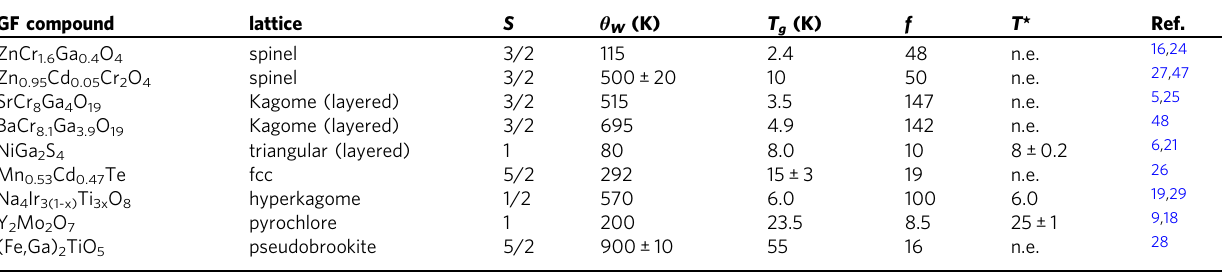
Table 1 Strongly geometrically frustrated magnets and their magnetic lattice, atomic spin ( S ), AF Weiss constant θ W , glass transition temperature T g , frustration parameter f ¼ θ an